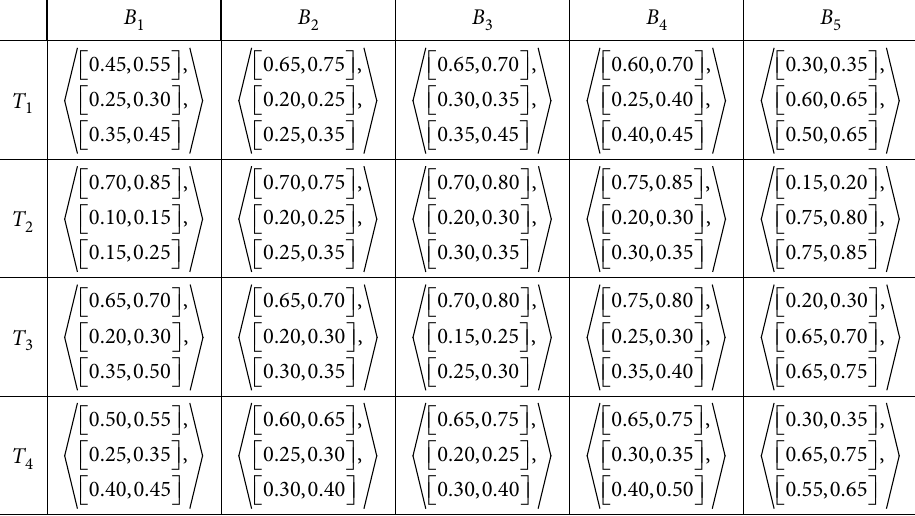
Table 2. Decision matrix